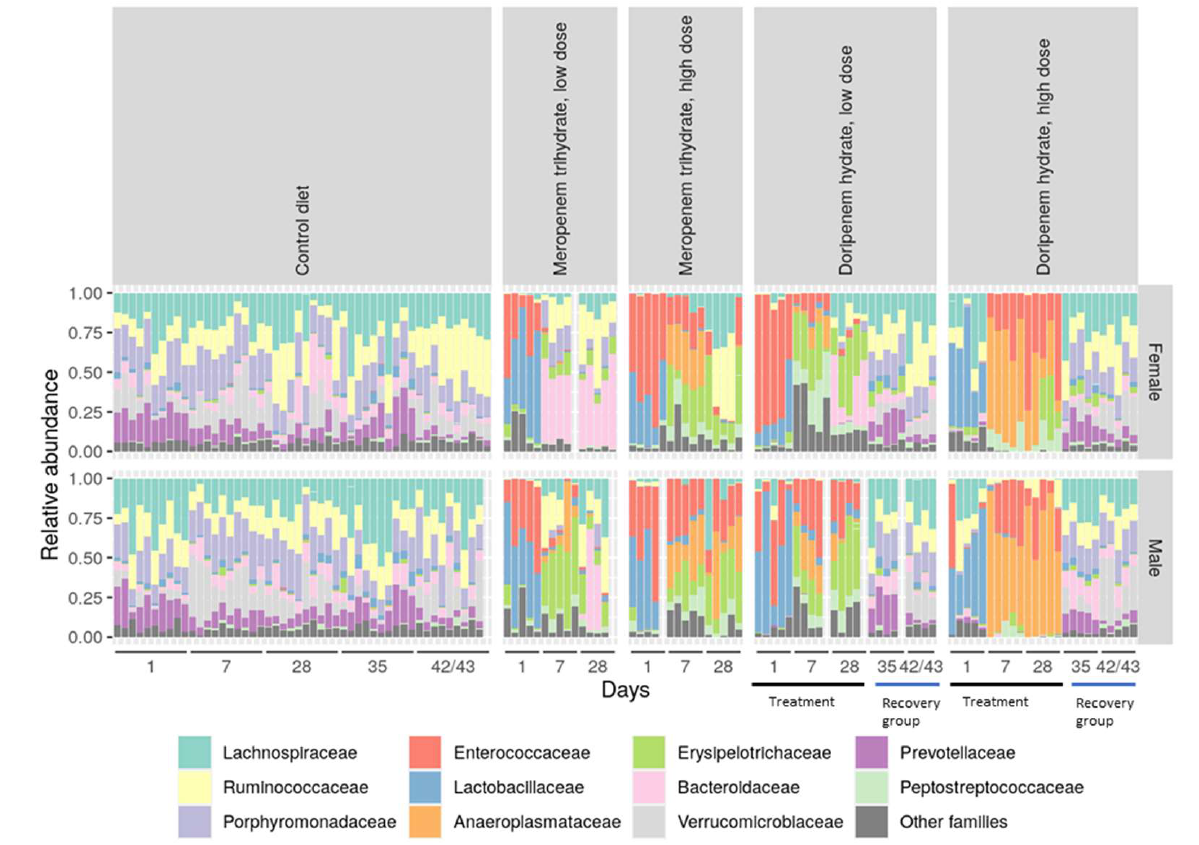
Figure 5. Stacked bar diagram showing relative abundances of the detected bacterial families in the different experimental groups. Inter-individual variability in the composition can be observed. Dose groups and sexes showed significant differences specifically in samples from days 1, 7, and 28 relative to the controls. Antibiotic-specific effects were observed on the intestinal community composi- tion. For the doripenem group, treatment time points, i.e., days 1, 7, and 28, and recovery time points, i.e., 35 and 42/43, are highlighted with black and blue lines on the x-axis, respectively.